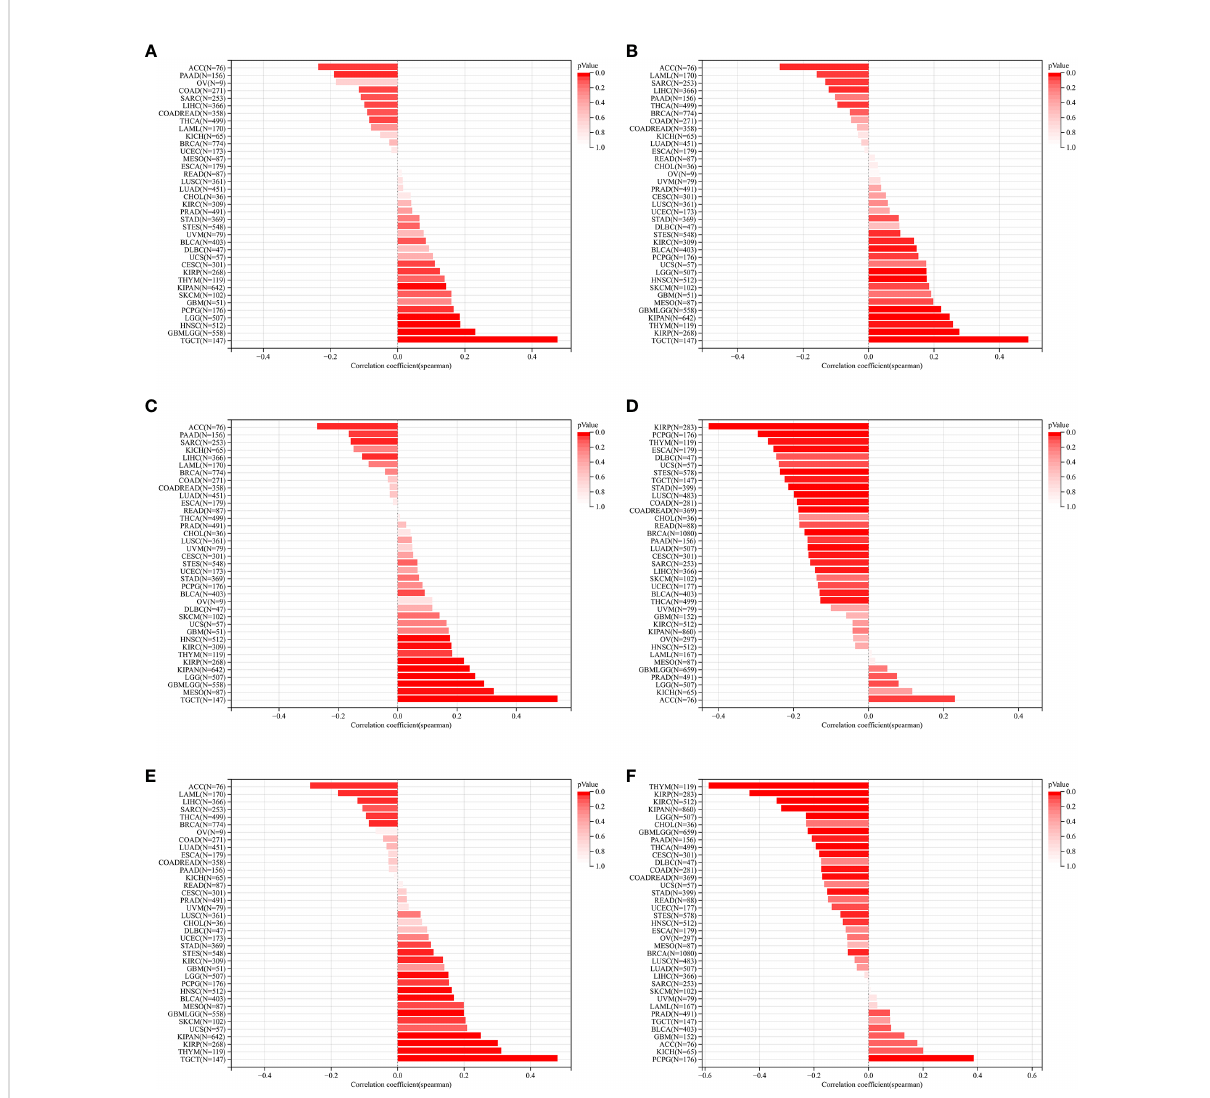
FIGURE 3 The pan-cancer Spearman analysis of tumor stemness andZNF419 expression. (A) the correlation between tumor stemness and ZNF419 expression level using DMPss; (B) the correlation between tumor stemness and ZNF419 expression level using DNAss; (C) the correlation between tumor stemness and ZNF419 expression level using ENHss; (D) the correlation between tumor stemness and ZNF419 expression level using EREG.EXPss; (E) the correlatiom between tumor stemness and ZNF419 expression level using EREG-MATHS; (F) the correlation between stemness and ZNF419 expression level using